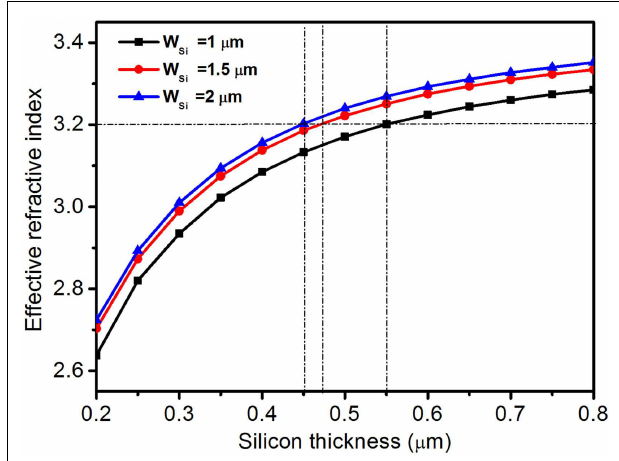
FIGURE 7 | Effective refractive index of the silicon waveguide fundamental mode as the function of silicon waveguide thicknesses . Both top and bottom claddings are oxide ( n = 1.45) and silicon index is chosen as 3.48 at the wavelength of 1550nm.